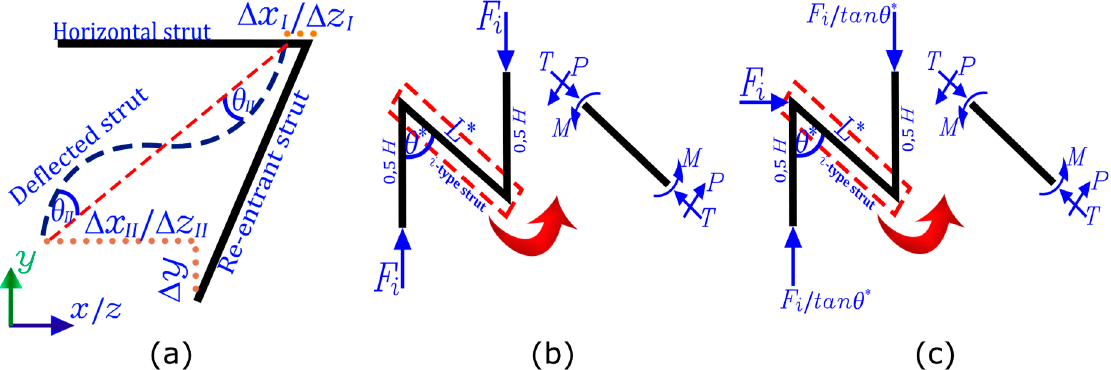
Figure 2. Simplified analysis of the auxetic structure, where ( a ) corresponds to the deformations of each re ‐ entrant strut; ( b ) shows the distribution of the internal loads under compression on the 𝑦 axis; while ( c ) shows the distribution of the internal loads under compression on the 𝑥 and 𝑧 axes.